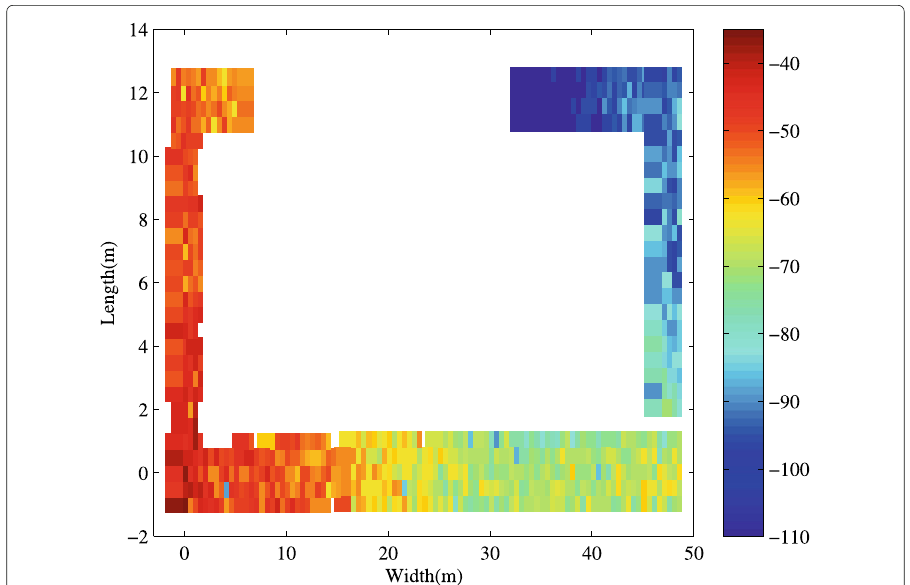
Fig. 4 Signal distribution in corridor of 12th Floor of 2A Building at Harbin Institute of